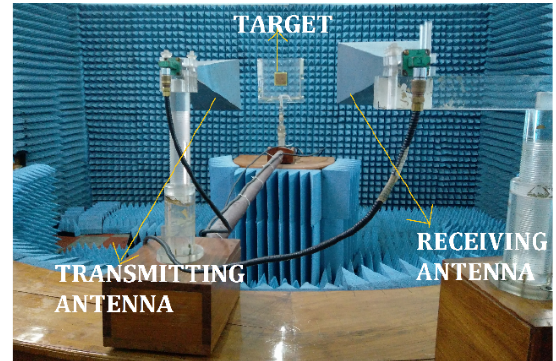
Figure.11. RCS Measurement Set up (Both the antennas are